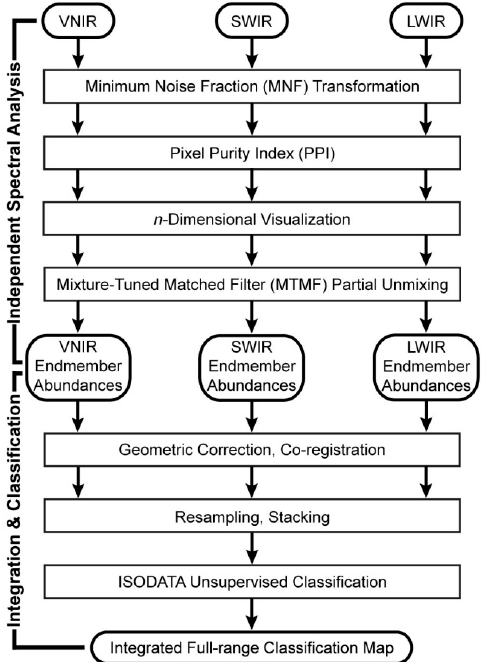
Figure 3. Methods flow chart summarizing the process used in the independent spectral analysis of each wavelength range and the subsequent integration and classification of the resulting endmember abundances. The rounded boxes indicate data products, and the rectangular boxes indicate procedures.